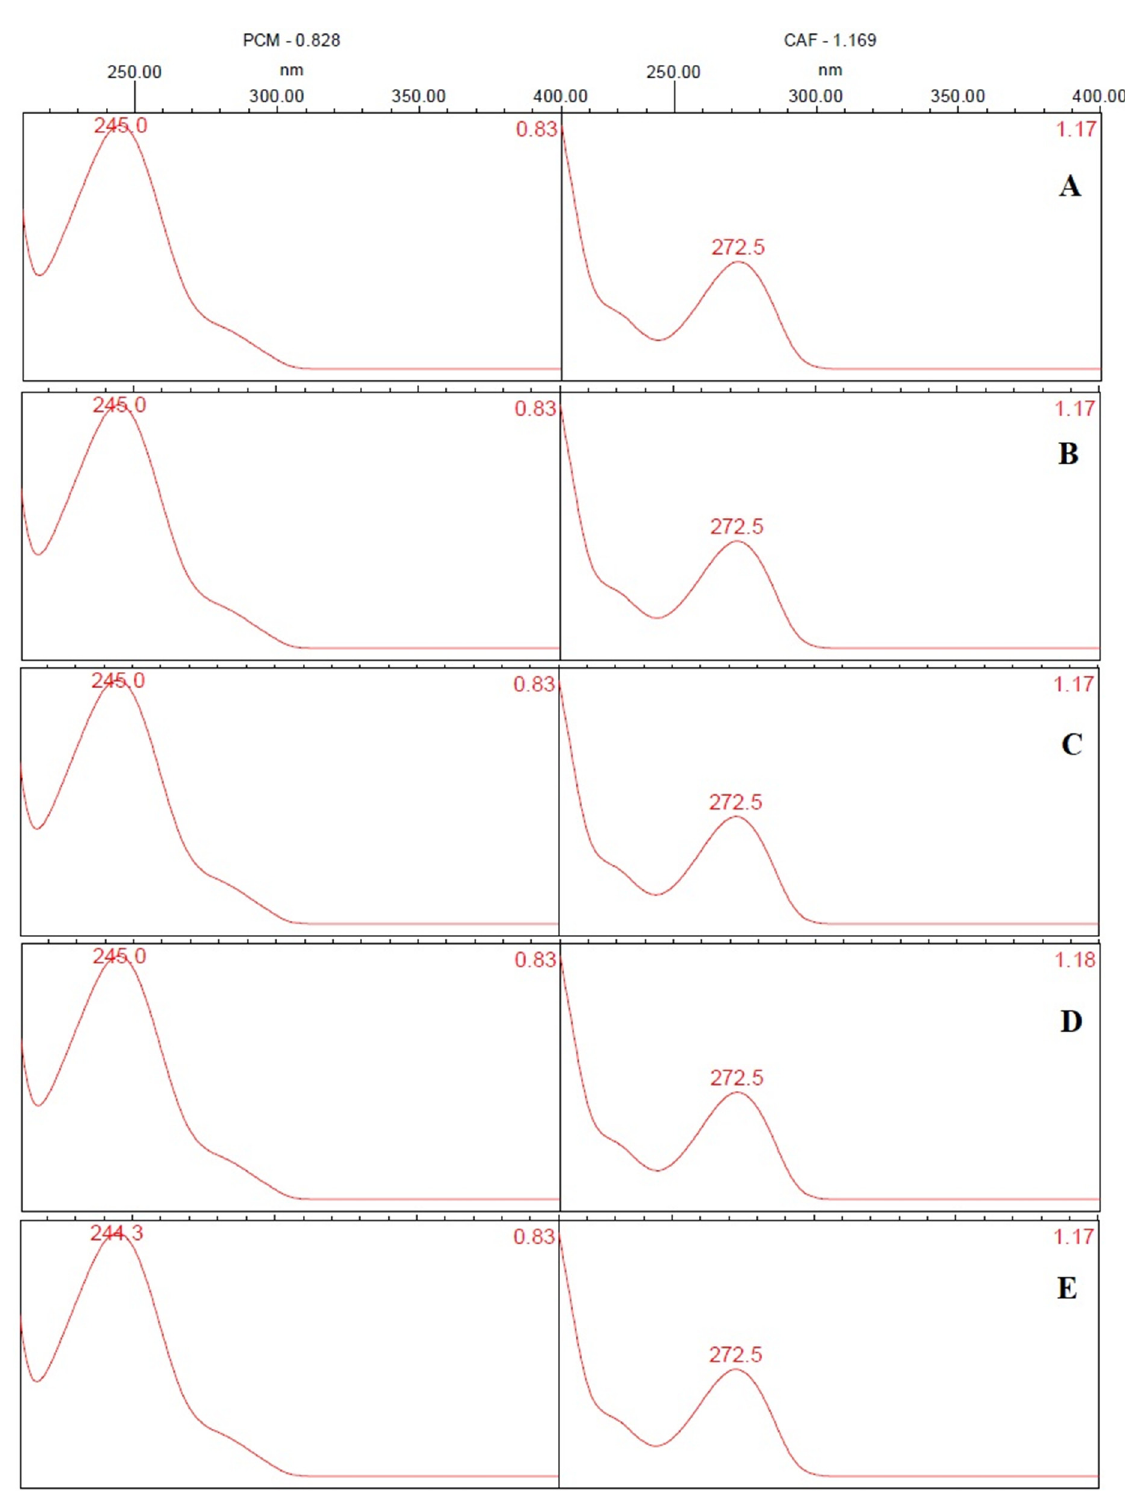
Figure 2. Spectra of PCM and CAF obtained via PDA detector in ( A ) standard, ( B ) Tab-1, ( C ) Tab-2, ( D ) Tab-3, ( E )